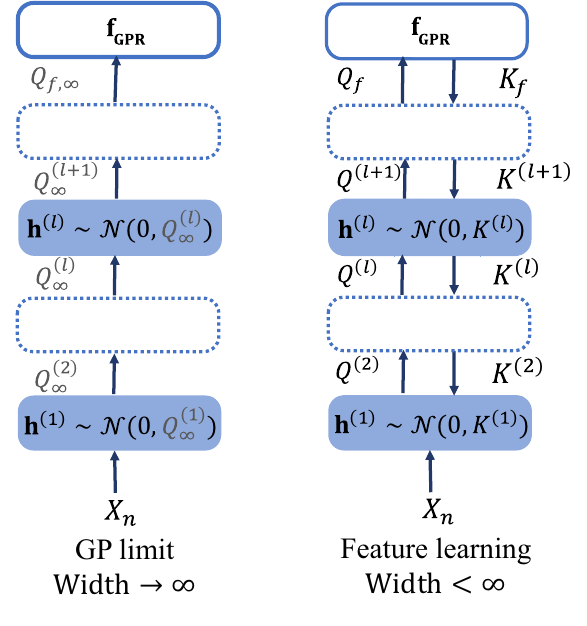
Fig. 1 | Feature learning regime versus Gaussianprocess in fi nite limit. Learning as described by our effective theory for antisymetric activation functions. Left: for in fi nite width the pre-activations (h ( l ) ), and the output (f) fl uctuate according to a Gaussian distribution with fi xed post-kernels Q ð l Þ 1 , Q f , ∞ , respectively. The complete set of slow variables are the outputs with fi xed kernels. Right: for large but fi nite width and number of samples, we obtain an approximately Gaussian distribution for the pre-activations and outputs with learned pre-kernels K ( l ) and K f = Q f + σ 2 I n , respectively. The outputs follow a Gaussian Process Regression (GPR) with kernel Q f . The complete set of slow variables here are both the outputs and the pre and post-kernels. For general activation, an additional slow variable, corresponding to the mean of the preactivation, needs to be